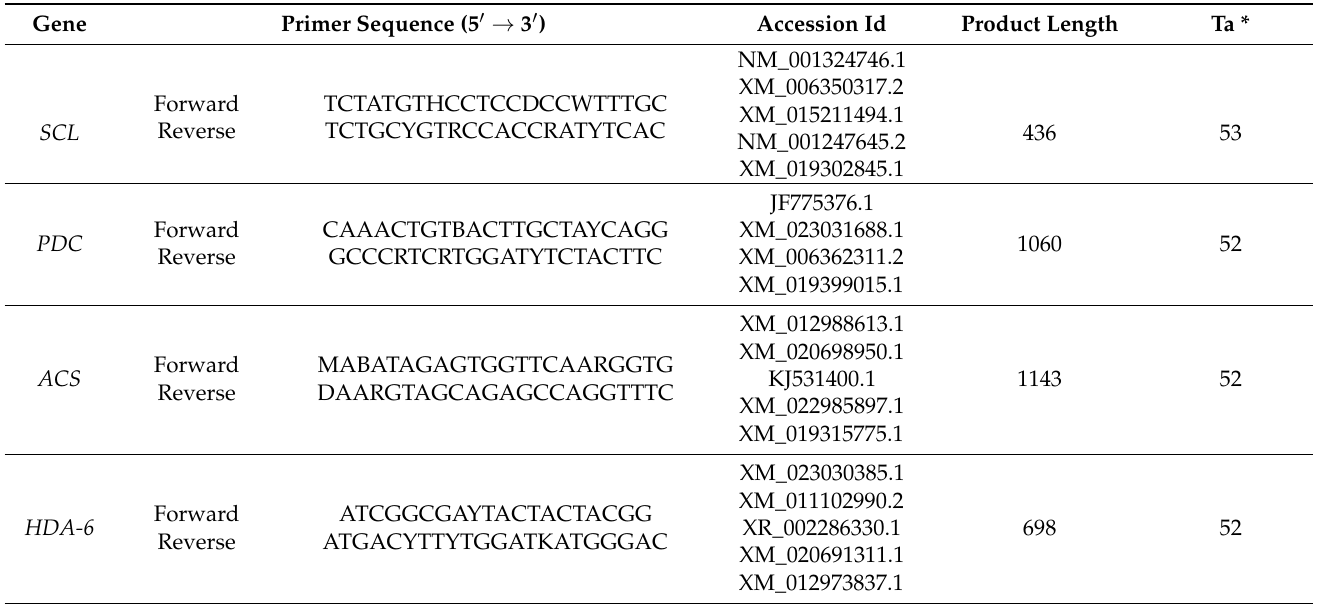
Table 1. Characteristics of degenerate primers and GenBank accession ID of sequences used for finding the conserved